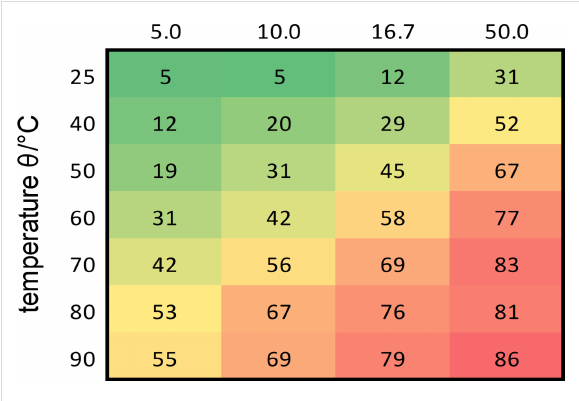
Figure 2: Optimization of the Baeyer–Mills reaction of nitrosobenzene ( 3 ) with aniline ( 2a ) to AB ( 1a ). The numbers in the figure result from the ratio of the integral of the HPLC peak of AB ( 1a ) to the integral of AB ( 1a ), nitrosobenzene ( 3 ), and aniline ( 2a ) at a wavelength of 254 nm (see Supporting Information File 1 for details).